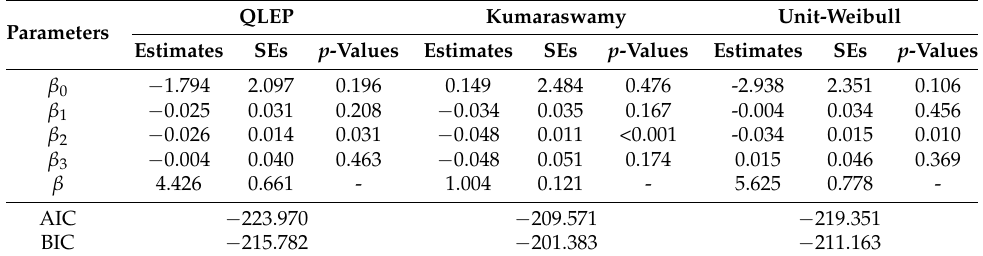
Table 3. Estimated parameters and model selection criteria of the fitted quantile regression models Parameters